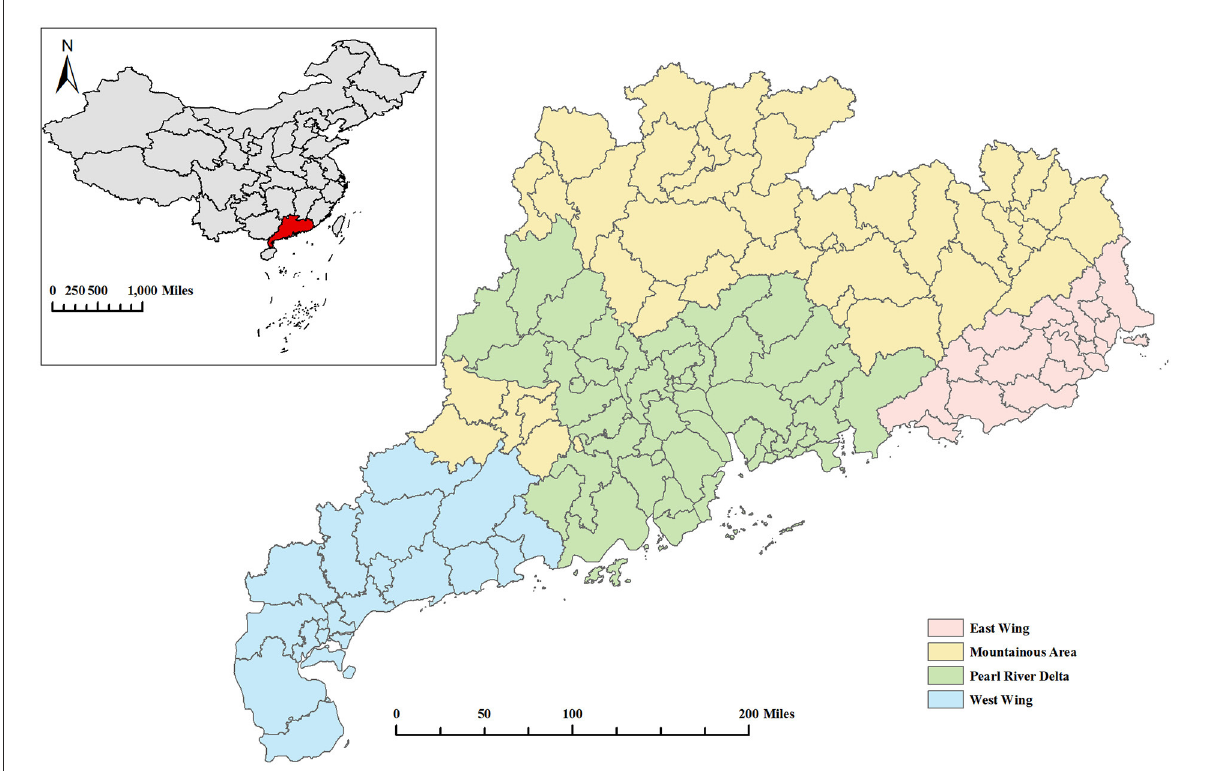
FIGURE1 The location of Guangdong Province and the division of its four regions. Base layer of the map was downloaded from Resource and Environment Science and Data Center